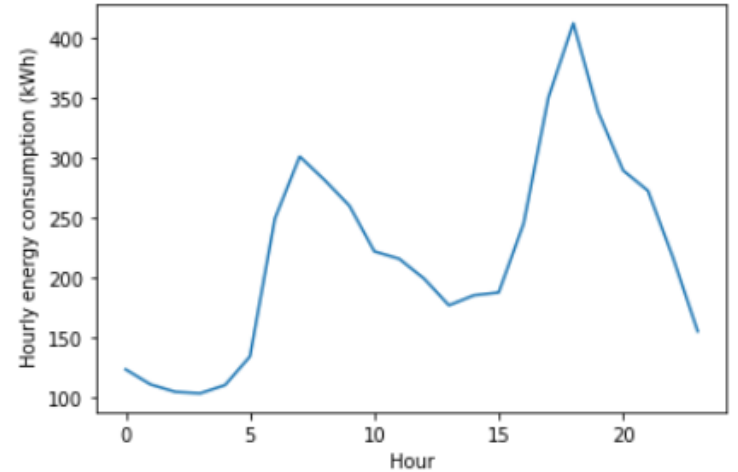
Figure 4. Hourly energy consumption by day.